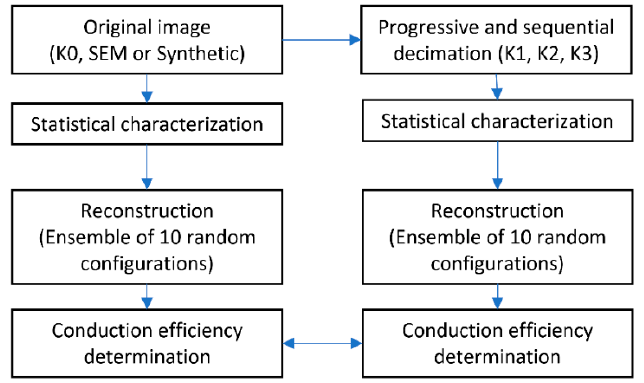
Figure 1. Diagram of the methodology used.